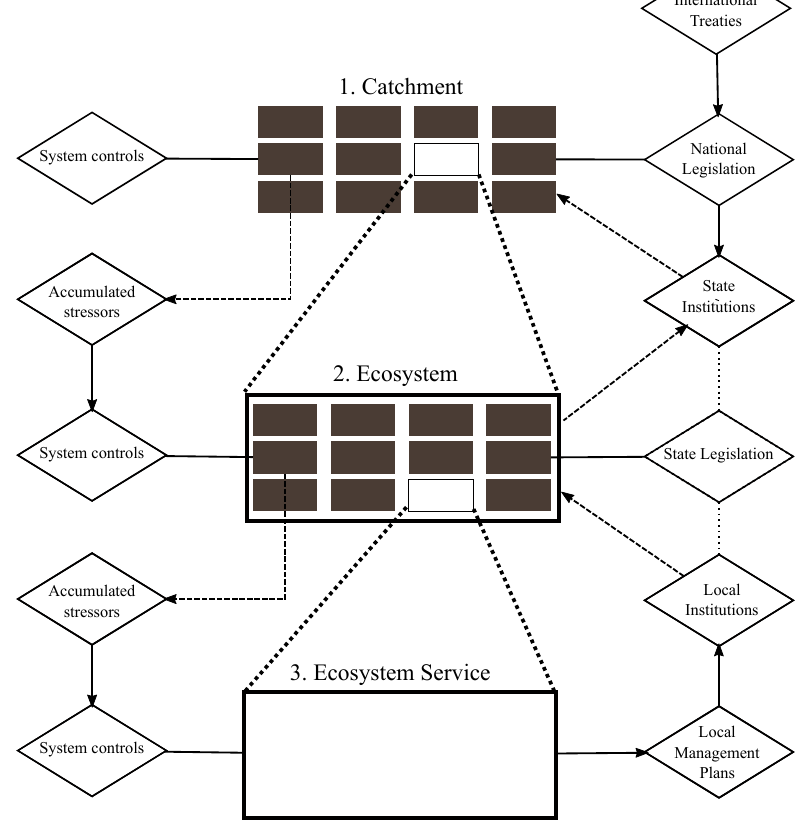
Figure 5. Ecosystem and legislative organisation: across spatial levels of ecosystem organisation stressors are accumulated and trigger a response for system controls in the legislative organisation. Due to fragmented legislative organisation responses are inadequate to maintain ecological resilience.